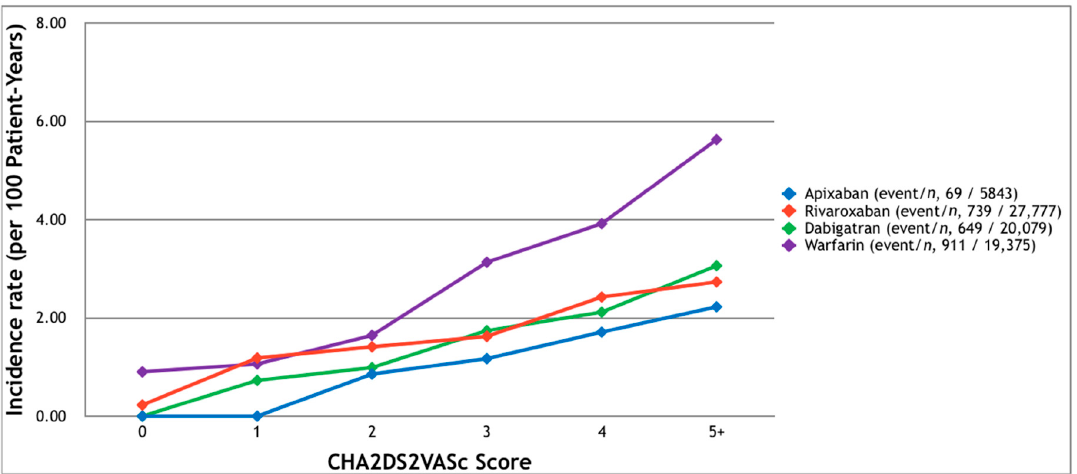
Figure 2. The incidence of major bleeding which required hospitalization among patients with non-valvular atrial fibrillation and receiving oral anticoagulants. Major bleeding occurred more frequently in patients with higher CHA 2 DS 2 -VASc scores.